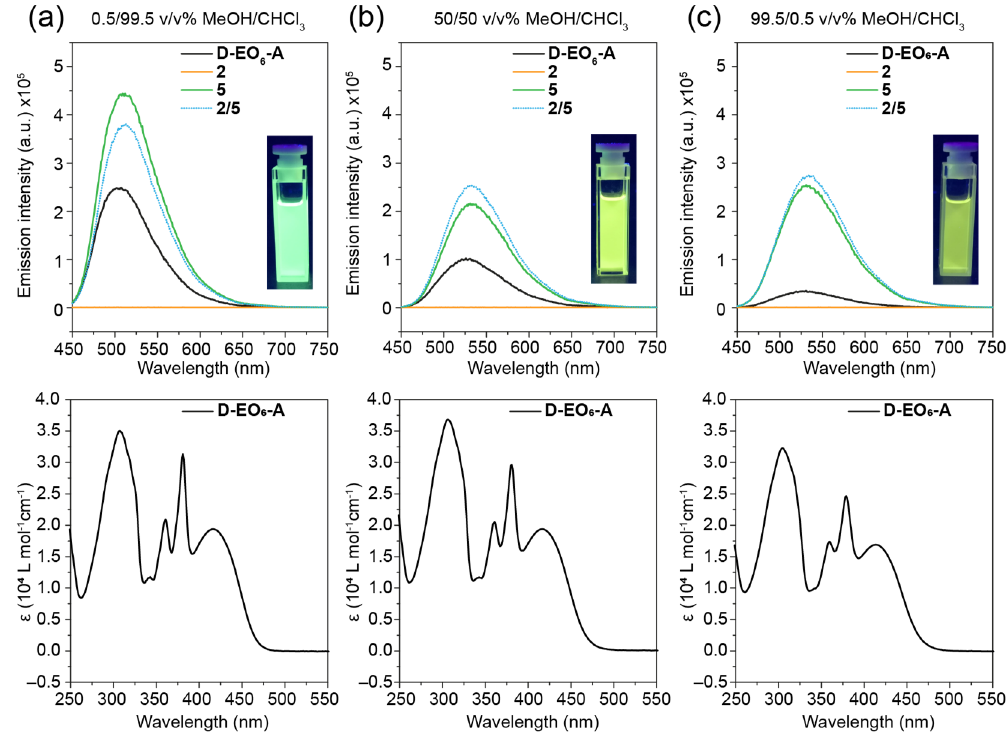
Figure 4. Emission spectra ( top ) and UV-vis absorption spectra ( bottom ) of D-EO 6 -A and reference compounds 2 and 5 as well as of equimolar mixtures of 2/5 in MeOH/CHCl 3 solutions of ( a ) 0.5:99.5, ( b ) 50:50, and ( c ) 99.5:0.5 v / v %. The insets show photographs of the solutions that were illuminated by UV light (365 nm). The concentration of all solutions was 10 µmol L − 1 , and an excitation wavelength ( λ ex ) of 417 nm was used.